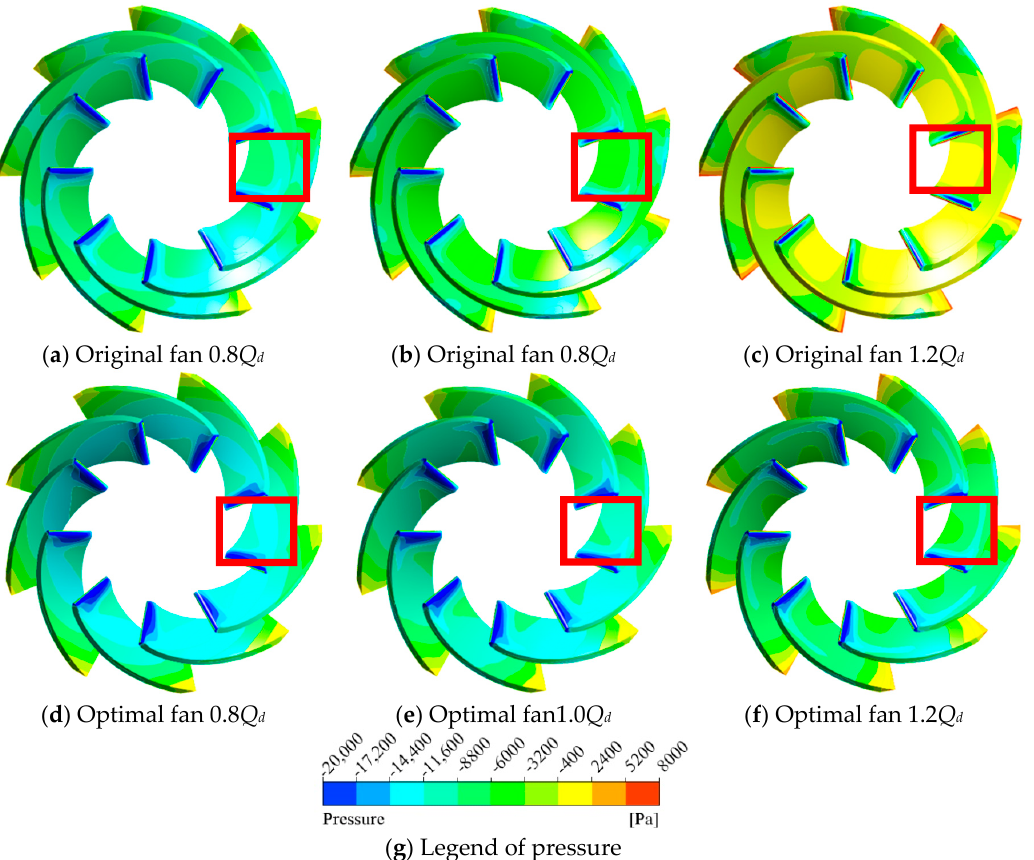
Figure 6. Pressure distribution of suction side in impeller. ( a ) Original fan 0.8 Q d ; ( b ) Original fan 0.8 Q d ; ( c ) Original fan 1.2 Q d ; ( d ) Optimal fan 0.8 Q d ; ( e ) Optimal fan 1.0 Q d ; ( f ) Optimal fan 1.2 Q d ; ( g ) Legend of pressure.